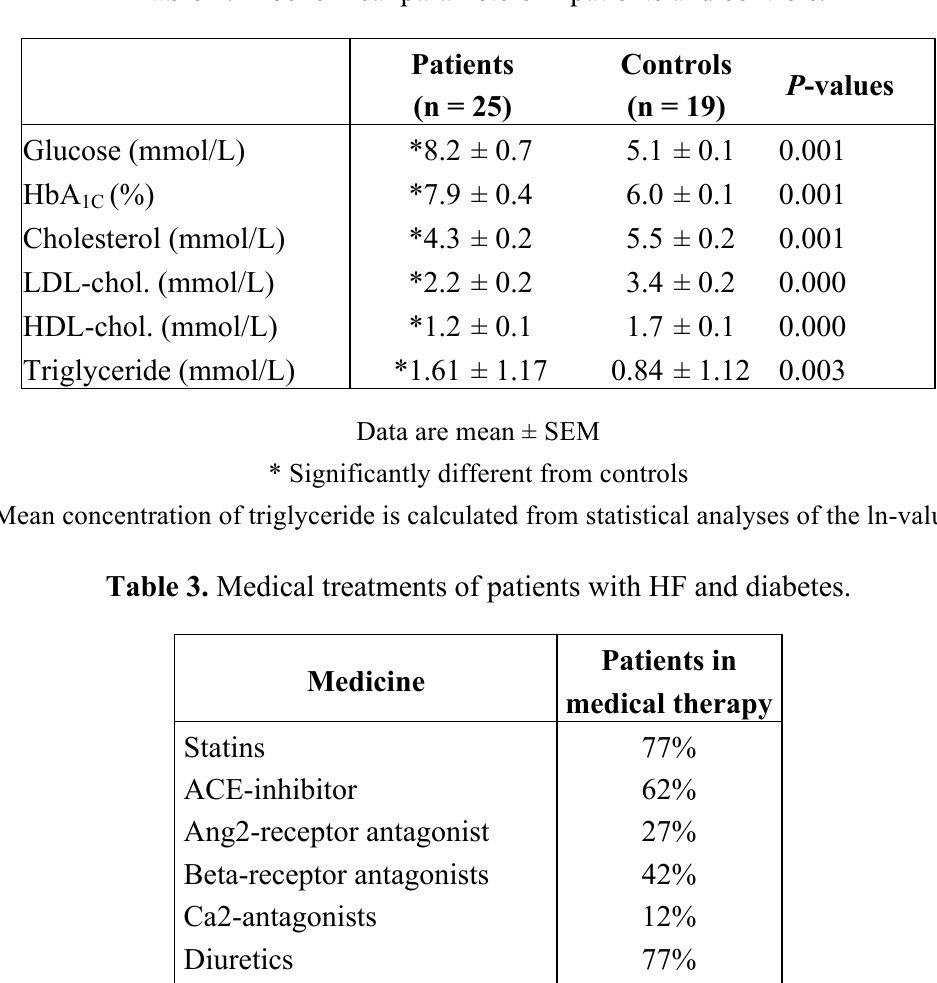
Table 2. Biochemical parameters in patients and controls.